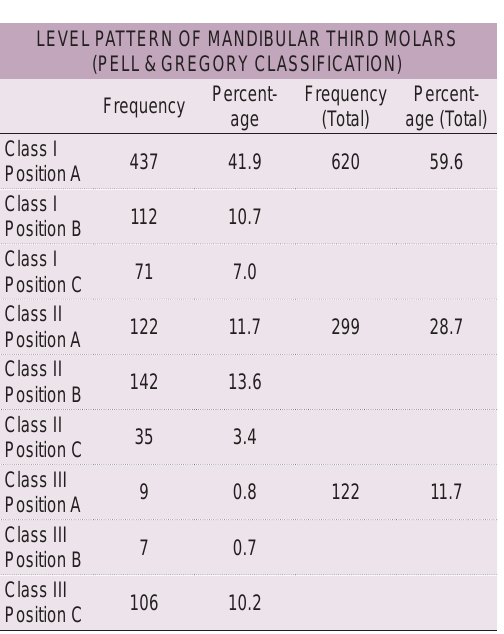
FIGURE 1. Angulation pattern of impacted mandibular third molars (based on Winter’s classifi cation). TABLE 3. Level pattern of mandibular third molars according to the classifi cation of Pell and Gregory.